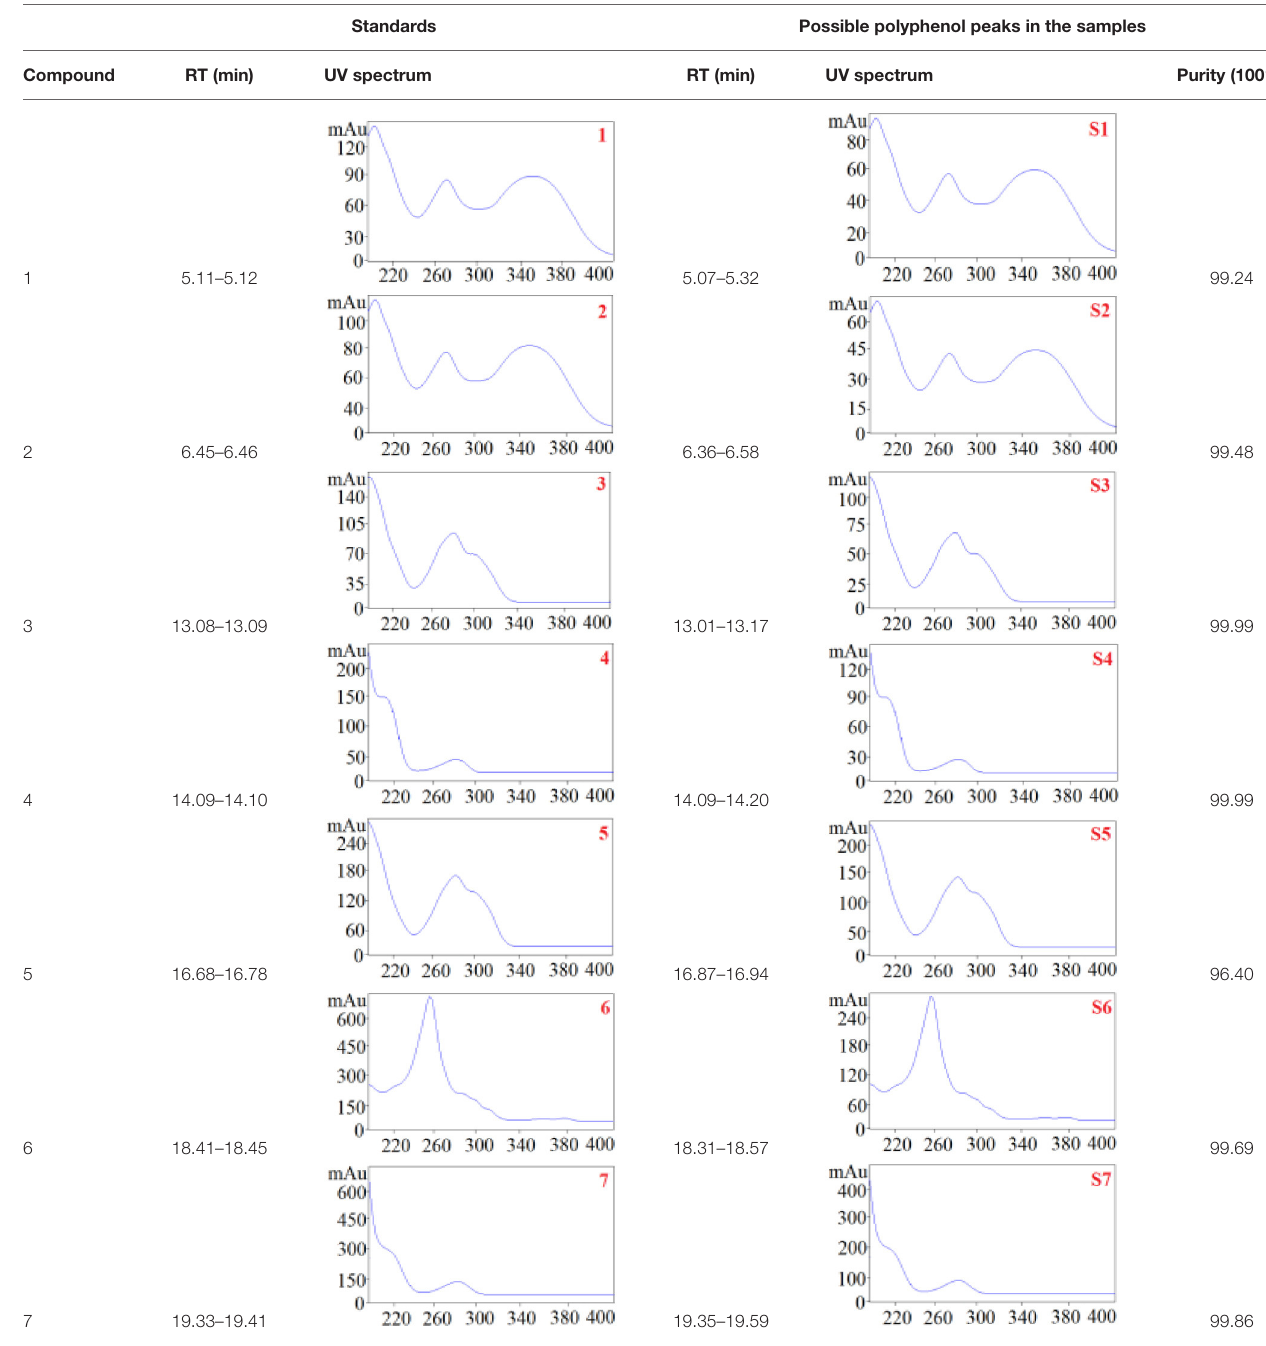
TABLE 1 | The RT and the UV spectra of the standards and the possible polyphenols obtained by HPLC-DAD